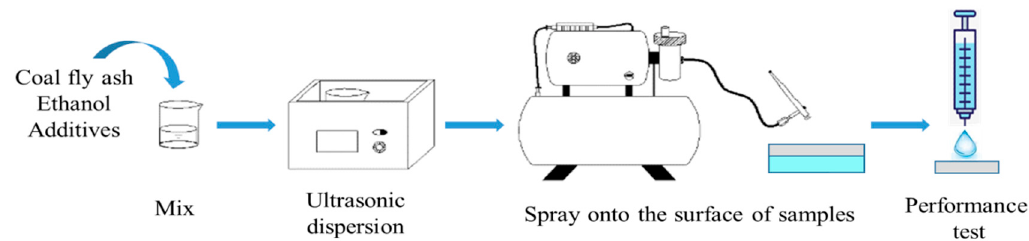
Figure 1. Preparation and application of the surface coating.